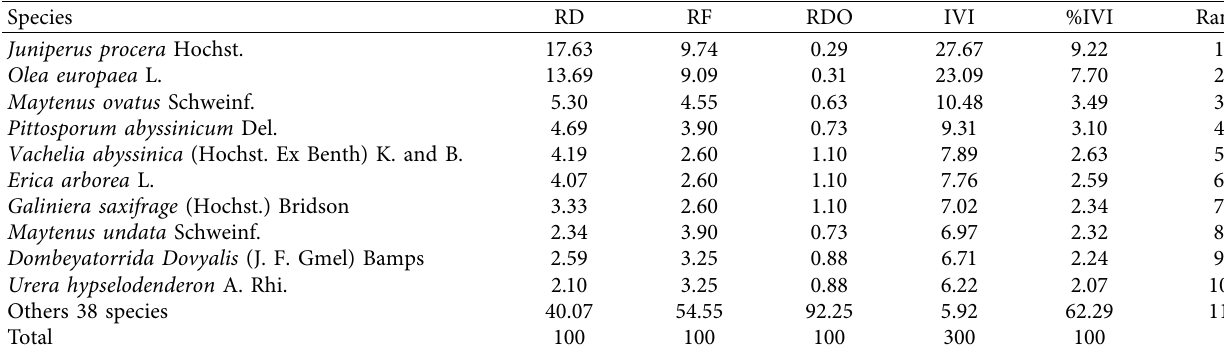
Table 3: List of woody plant species with high basal area and their percent contribution of BA m 2 ha − 1 in Zijje Maryam Church Forest. Species BA BA (m 2 ha − 1 ) % D (ha − 1 ) Juniperu procera Hochst. Olea europaea L. Vachelia abyssinica (Hochst. Ex Benth) K. and B. Maytenus undata (Tunb.) Blakelock Pittosporum abyssinicum Del. Galiniera saxifrage ( Hochst.) Bridson Maytenus ovatus Schweinf. Others 40 species Total